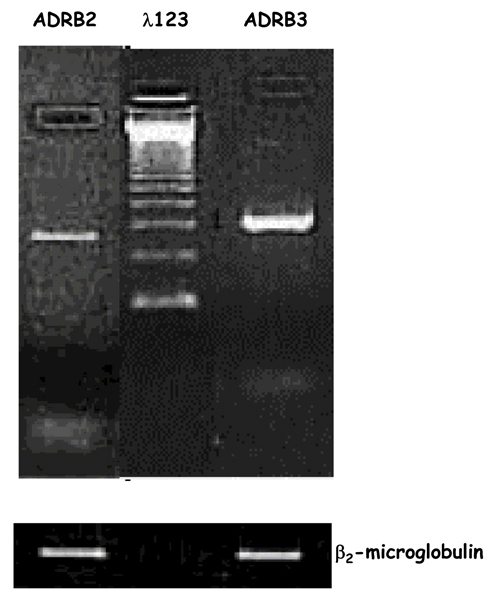
Representative RT-PCR analysis of the mRNA steady-state levels for ADRB2 and ADRB3 in human pregnant myometrium. The 123-bp DNA ladder (λ 123) was used to estimate the size of the PCR products, and beta2 microglobulin expression was used as a standard reference.